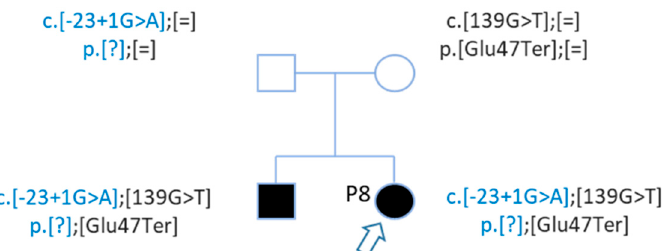
Figure 5. Pedigree of patient P8 with 2 GJB2 mutations in trans. Patient P8 and her brother carried 2 mutations in trans. Mutations were inherited from each parent.